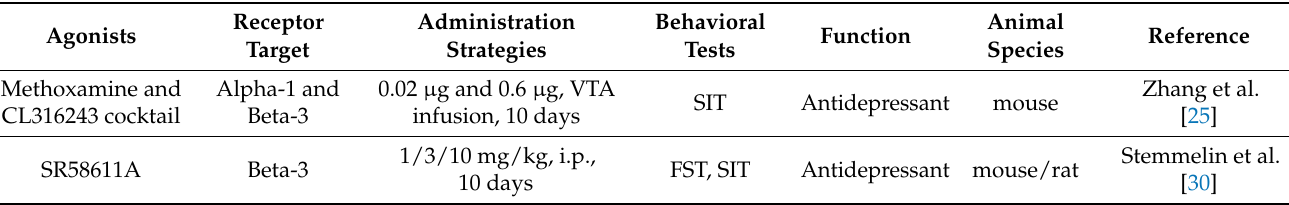
Table 2. Beta-adrenoceptor agonists tested in animal